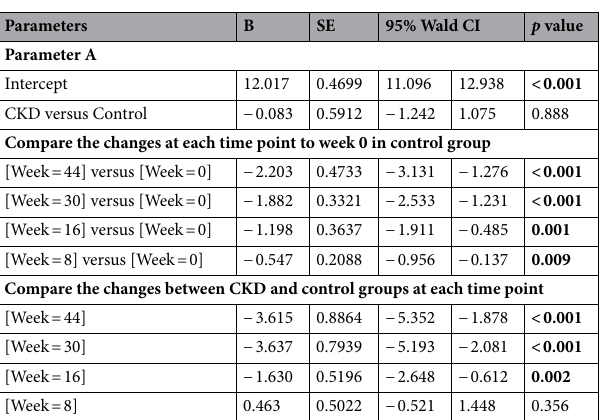
Table 2. Comparisons of perfusion parameter A between control and CKD groups over 44 weeks by GEE multiple linear regression. B: regression coefficient.